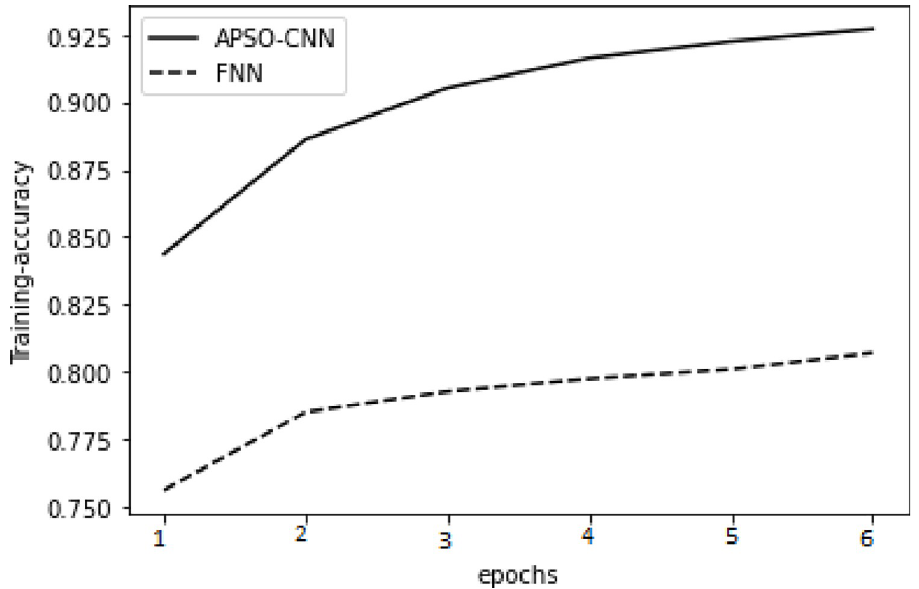
Fig 11. APSO–CNN and FNN algorithms’ accuracy training